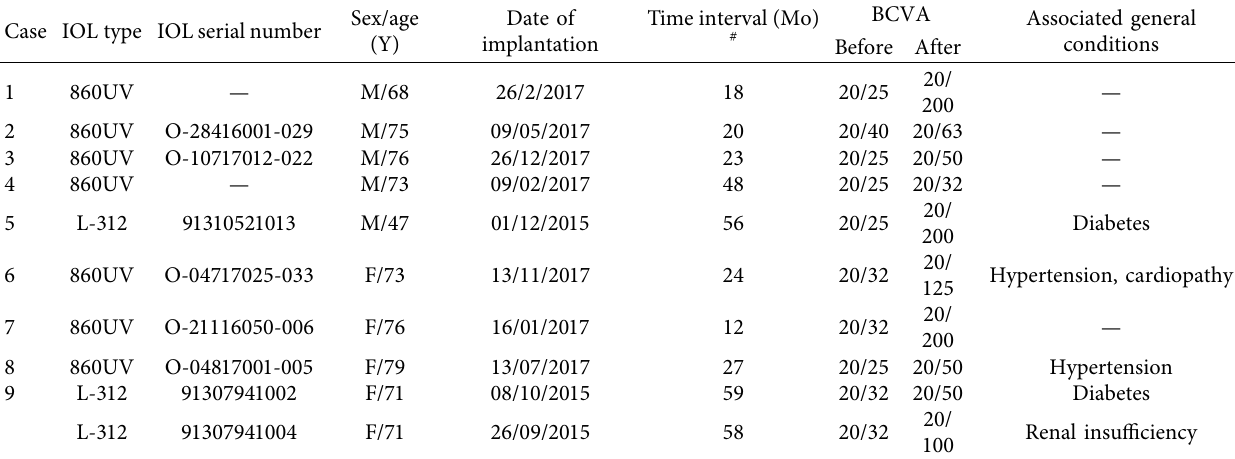
Table 1: Characteristics of the patients with postoperative IOL